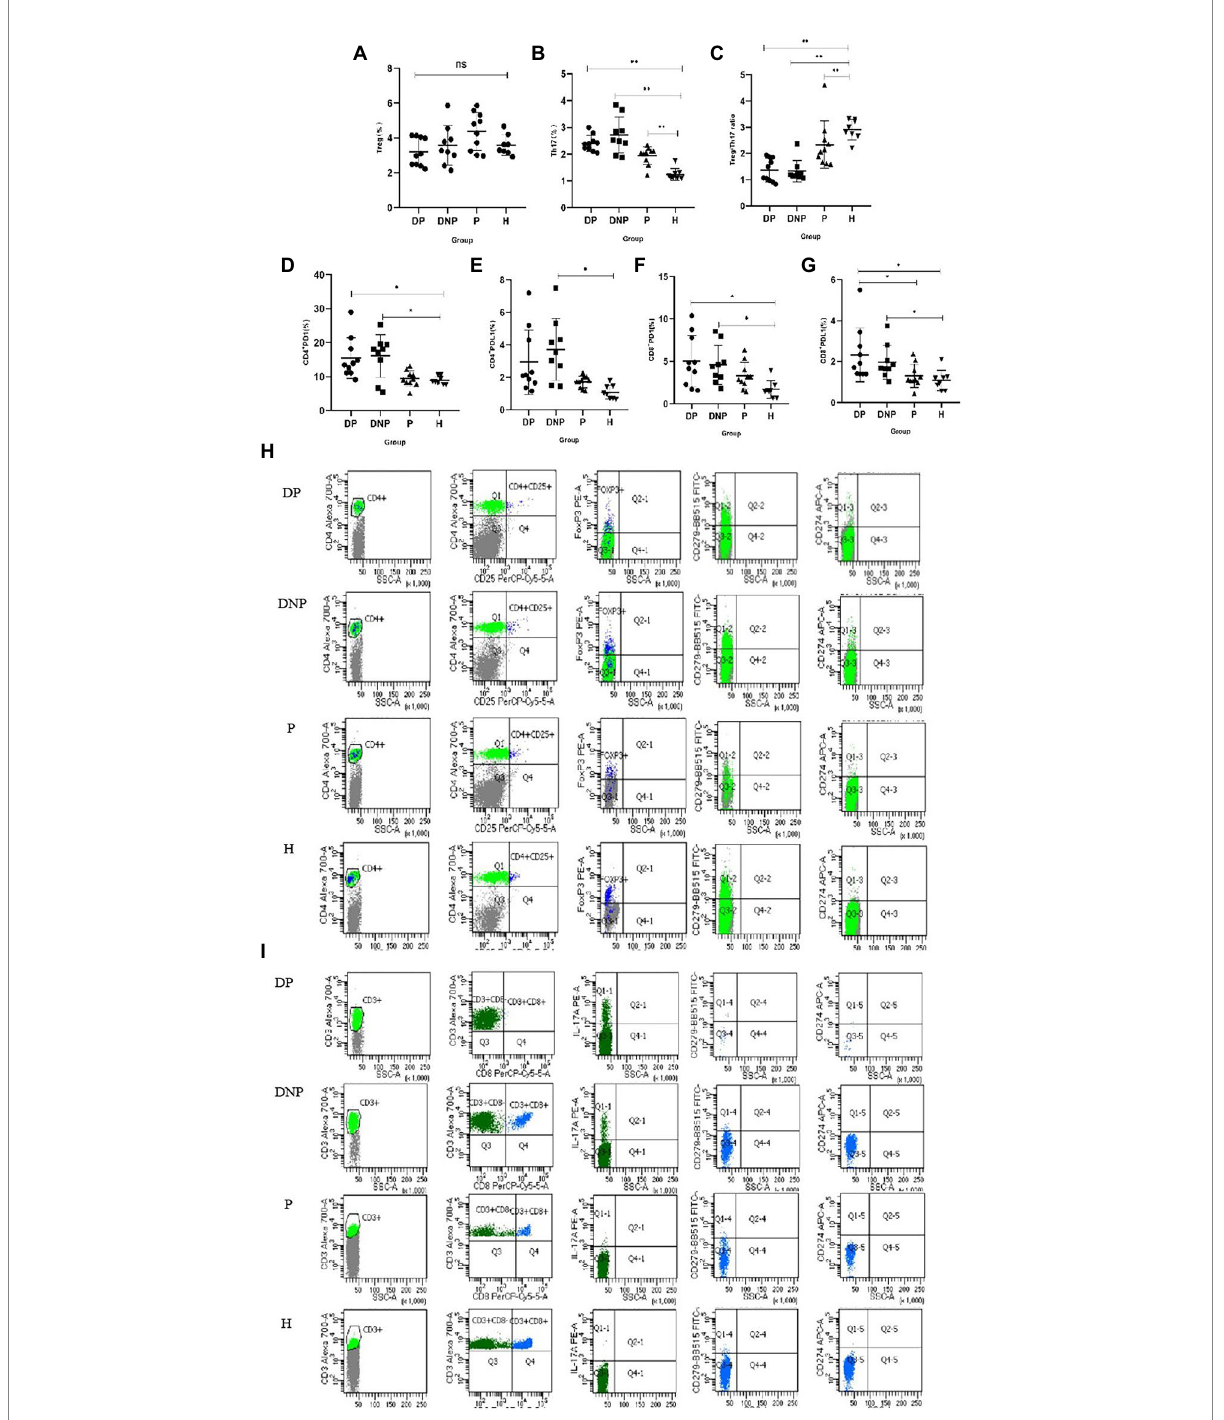
FIGURE 7 Percentage of Treg and Th17, Treg/Th17 ratio, and expression of PD1 and PDL1 in CD4 + and CD8 + T lymphocytes in peripheral blood. (A–G) : The percentage of Treg cells (A) , Th17 cells (B) , Treg/Th17 ratio (C) , and PD1/PDL1 CD4 + /CD8 + (D–G) in peripheral blood determined by flow cytometry. (H) Comparison of the frequencies of CD4 + CD25 + FoxP3 + T cells, CD4 + PD1/PDL1 cells in the DP, DNP, P, and H. (I) Comparison of the frequencies of CD3 + CD8-IL17 + T cells, CD8 + PD1/PDL1 cells in the DP, DNP, P, and H. * p < 0.05, ** p < 0.001 (one-way ANOVA test with Tukey’s multiple comparisons